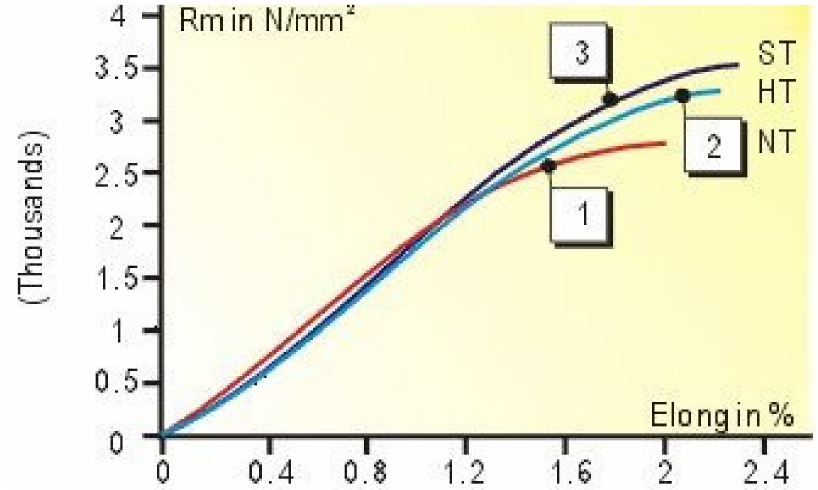
Figure 3. Tensile test data for 0.175 mm diameter filaments for (1) normal products, (2) high tensile grade, and (3) an experimental super-high tensile grade. Reprinted from ref. [4].